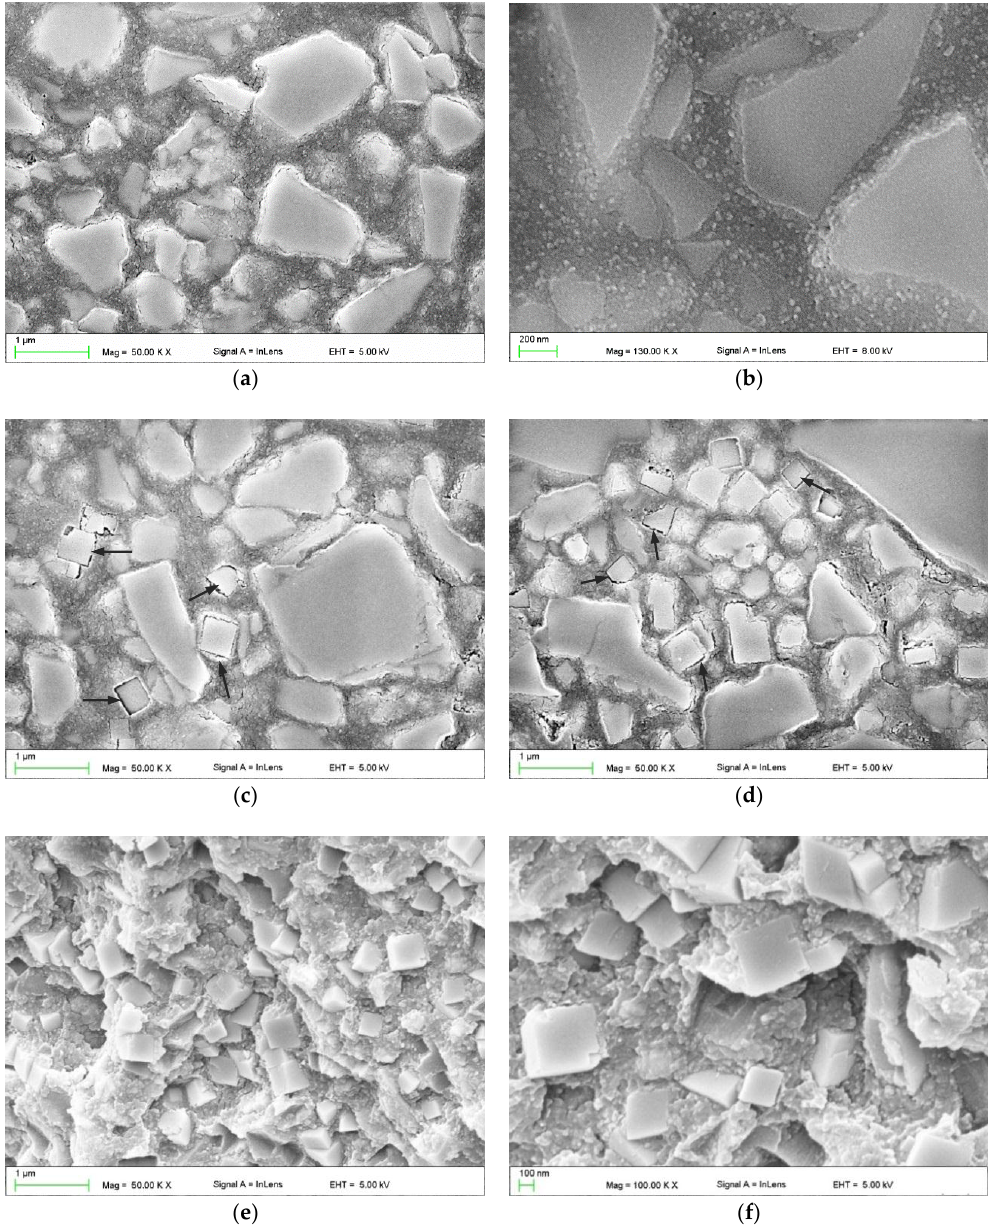
Figure 2. Representative SEM images presenting the morphologies of the cured base composite compounded with: reinforcing fillers ( a , b ); addition of 7% ( c ) and 16% ( c – f ) of silver sodium hydrogen zirconium phosphate; ( a – d )—wet-ground, polished, etched samples ( e , f )—frozen-broken but not etched samples, black arrows ( c , d ) indicate the gaps between SSZHP and matrix after